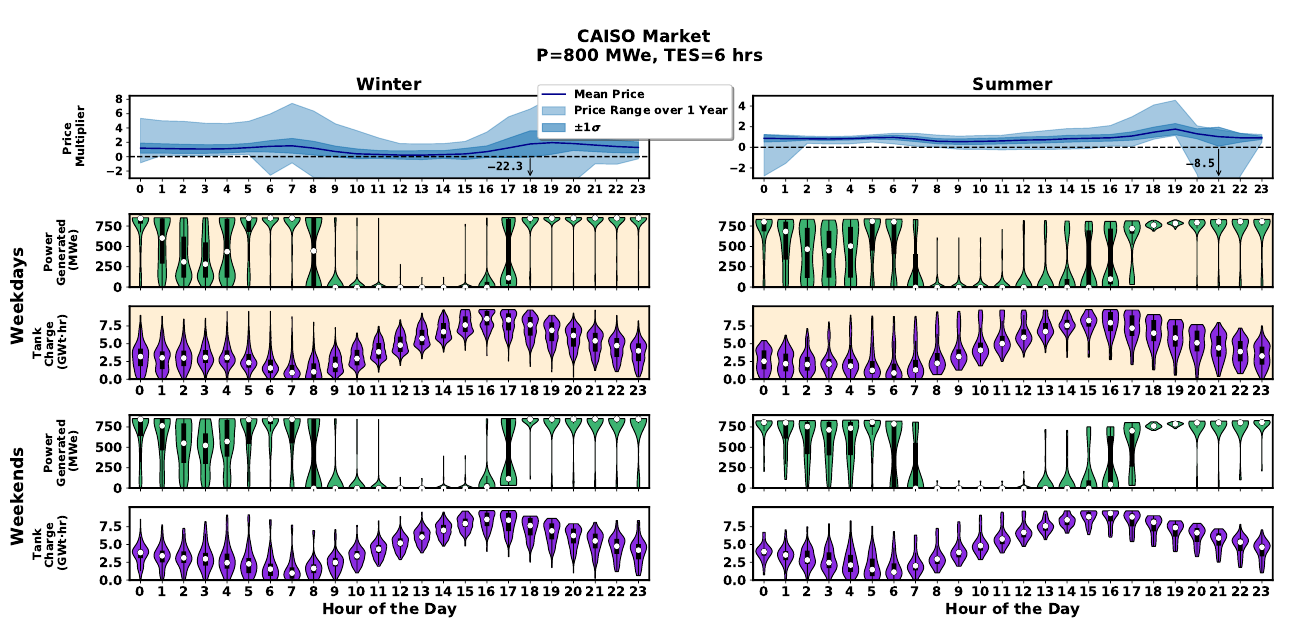
Figure 9. (Top row) Hourly ranges in normalized CAISO energy price multipliers for a full year. Mean price and standard deviation are shown in a darker shade. (Rows 2–5) Hourly violin plot distributions for a year of simulated electric power and stored energy levels. Computed for an 800 MW e turbine with 6 h of TES under normalized CAISO energy prices. Median value for each hour is shown as a white circle and the black vertical rectangle demarcates 25th and 75th percentiles. Distributions are split between Winter and Summer price schedules as well as weekday and weekend